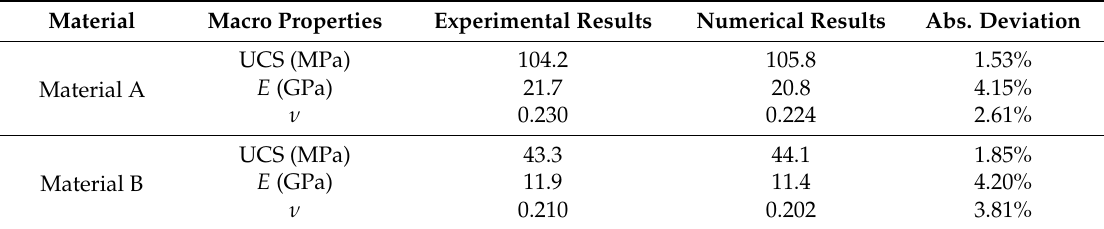
Table 2. Comparison of mechanical properties of intact material between the physical experiment and the particle flow modeling